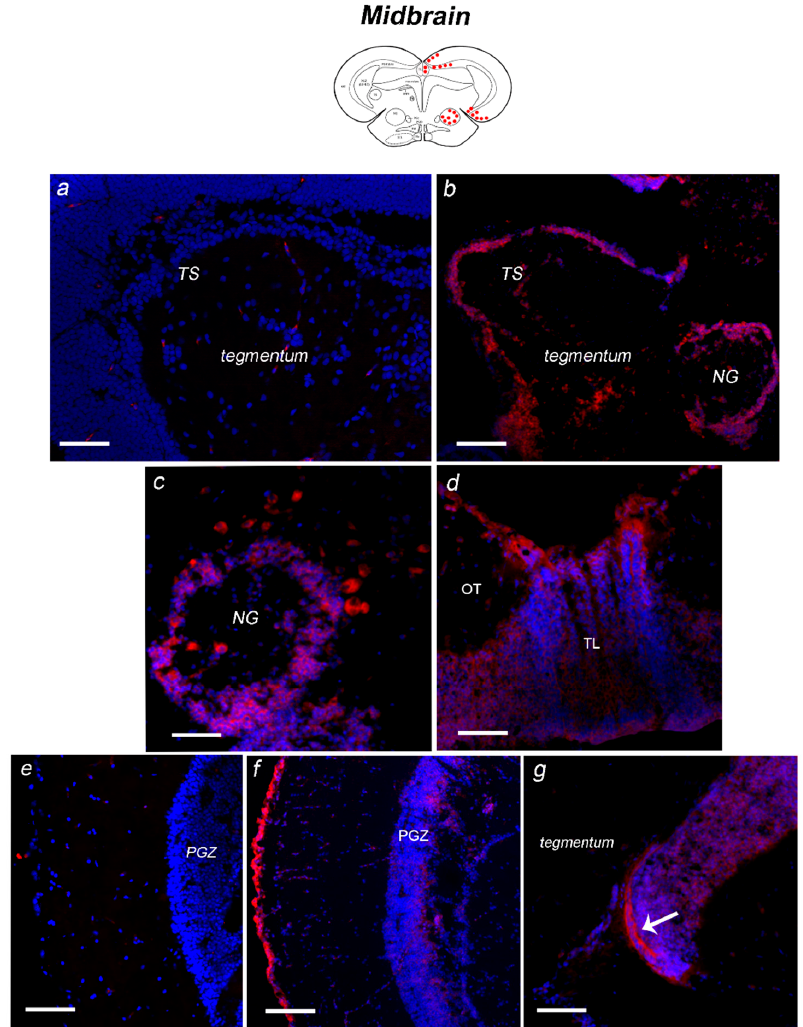
Figure 6. Expression of NT-6 mRNA in transverse section of caudal diencephalon/midbrain of adult N. furzeri. On the top, schematic drawings of N. furzeri brain, with red dots indicating NT-6 mRNA distribution over the different brain areas. Caudal diencephalon/midbrain: ( a ) sense probe staining in the anterior midbrain tegmentum; ( b ) high magnification of sense probe staining in the NG; ( c ) overview of tegmentum, with probe signal in neurons of TS and NG; ( d ) high magnification of positive neurons, scattered along the margin of NG; ( e ) probe signal in the dorsal and ventral part of TL and along the margin with OT; ( f ) few positive cells of PGZ in the anterior part of OT; and ( g ) numerous positive cells in the most caudal part of OT and intense staining at the margin between OT and the midbrain tegmentum (arrow). Scale bars: ( a , c ) 50 µm; and ( b , d – g ) 25 µm. Abbreviations: NG, glomerular nucleus; OT, optic tectum; PGZ, periventricular grey zone; TL, longitudinal tori; TS, semicircular tori.